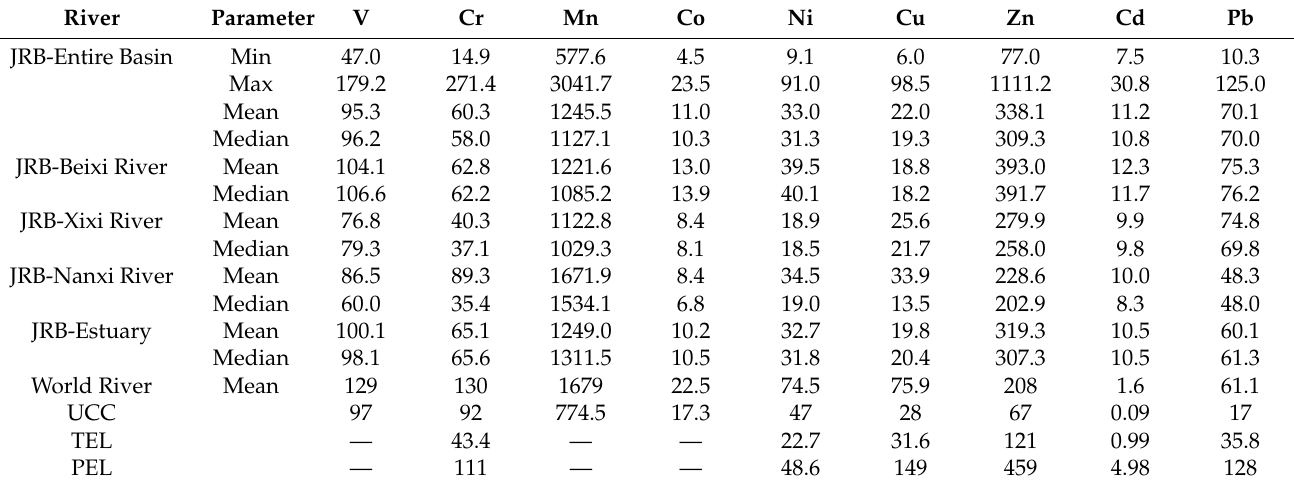
Table 1. The particulate PTEs’ contents in JRB and world rivers (mg kg − 1